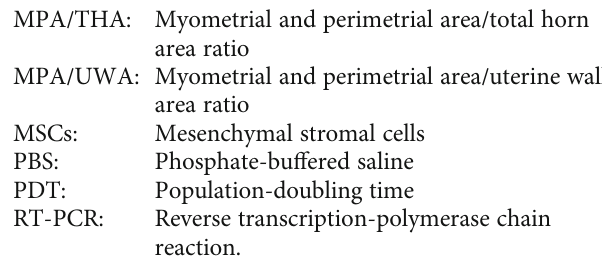
Supplementary Figure 1: the study design for the 12 rabbits indicating the treatment of 2 uterine horns in each rabbit. CM: conditioned media. Supplementary Figure 2: histologi- cal evaluation of the preventive e ff ects of intrauterine bone marrow-derived mesenchymal stromal cell- (BM-MSC-) conditioned media (CM) injection on uterine fi brosis after endometrial curettage in rabbits of all groups (Masson ’ s trichrome staining). (Supplementary